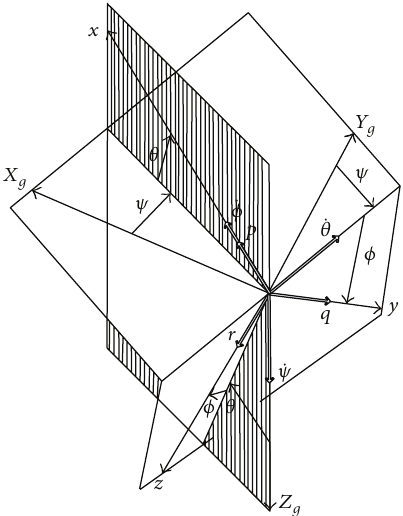
Figure 2: The relationships between angular velocity components and the attitude angle change